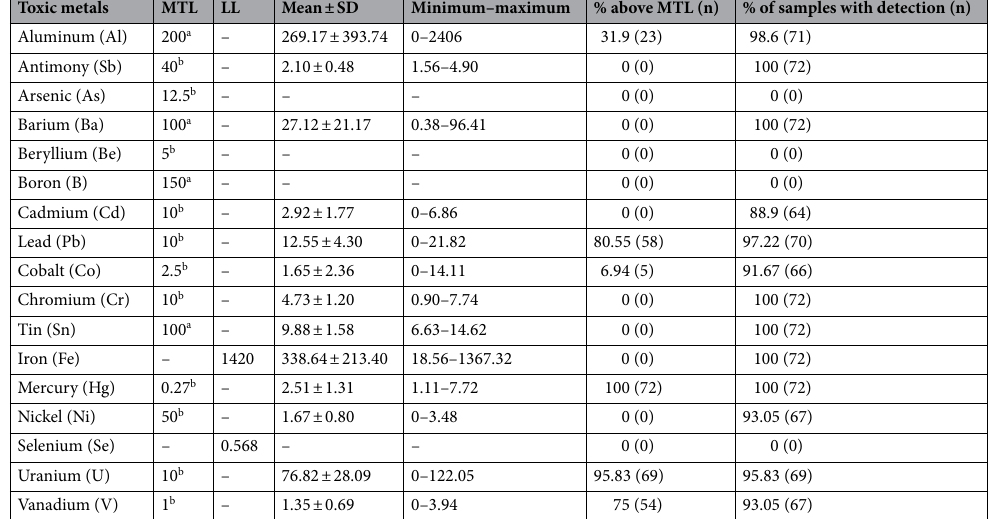
Table 4. Detected toxic metal concentrations (mg/kg DM) in the 72 dog foods evaluated and comparison with the maximum tolerated level established by the FDA (2011) and/or legal limit expressed by FEDIAF